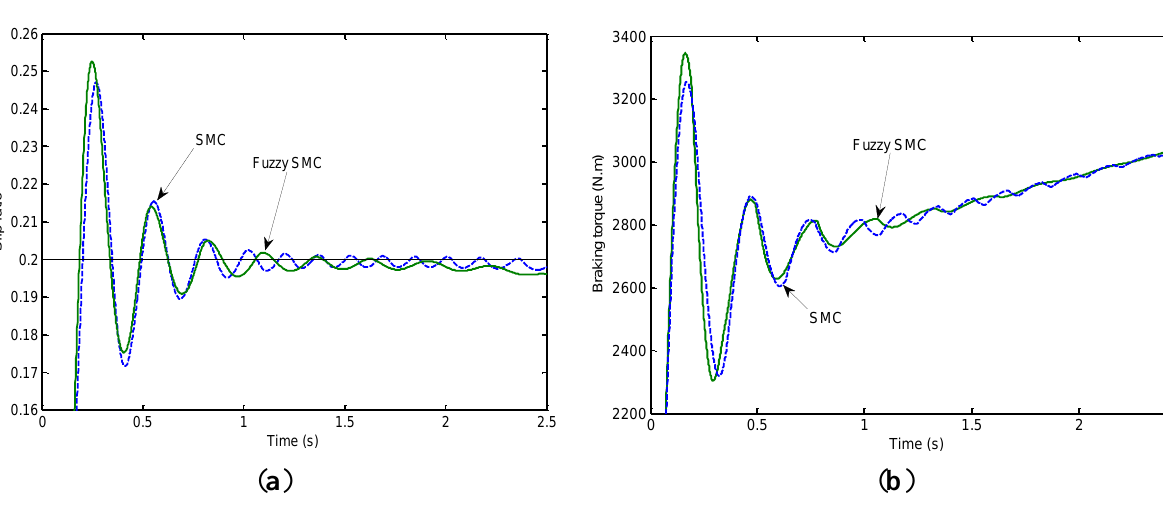
Figure 9. Comparison of: ( a ) slip ratio with the proposed SMC controller with and without optimizing parameter; and ( b ) actual braking torque acting on the front wheel with the proposed SMC controller with and without optimizing